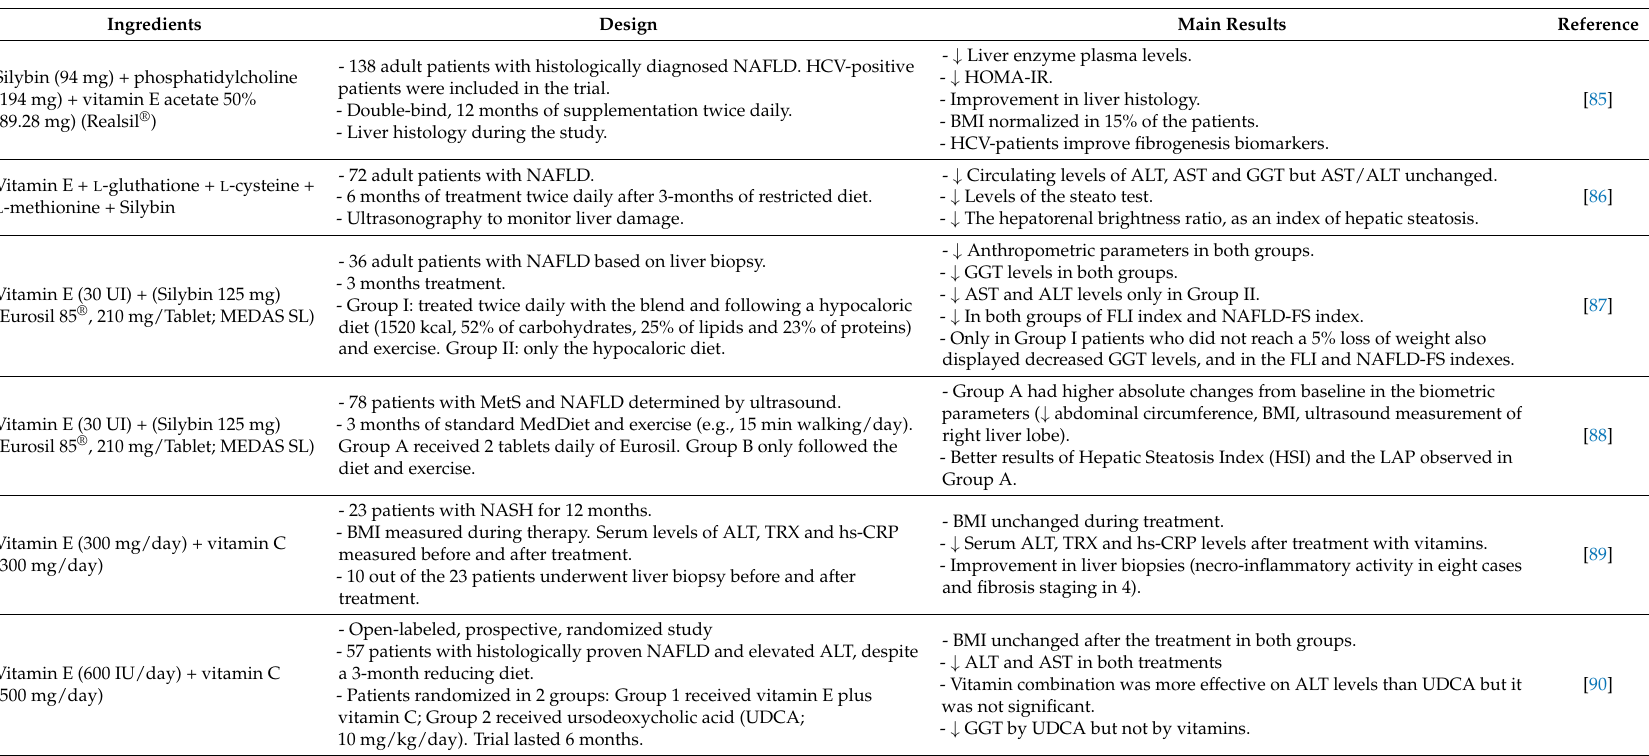
Table 2. RCT aimed to evaluate the effects of multi-ingredient approaches against NAFLD and